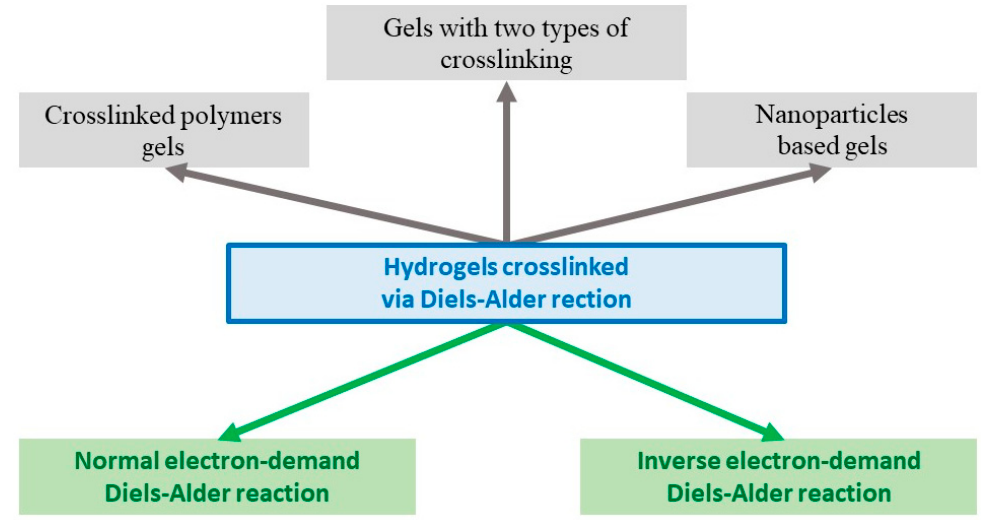
Figure 3. Classification of hydrogels obtained via Diels–Alder crosslinks.